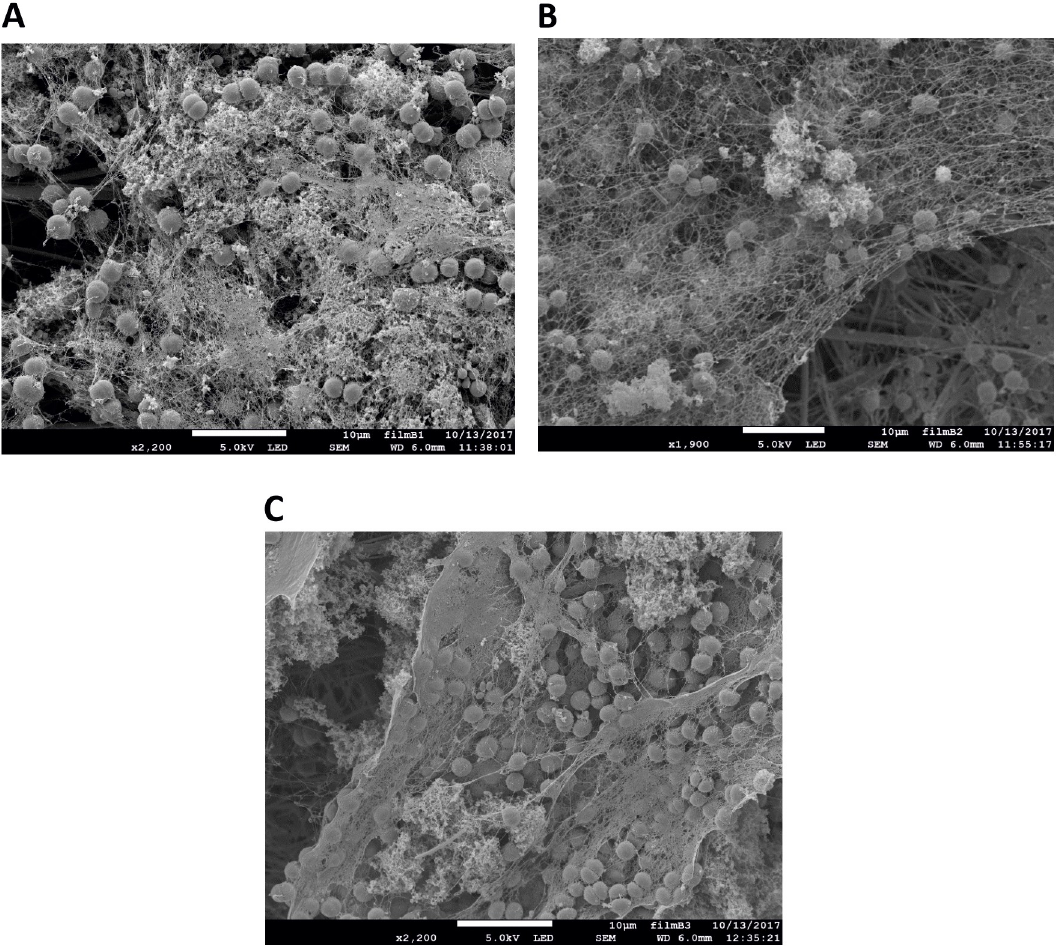
Fig 4. SEM of biofilm formation by Synechocystis on glass microfiber filter coated with PHB after 7 days of incubation. (A) 1 layer at 2200X magnification, (B) 2 layers at 1900X magnification, (C) 3 layers of PHB coating at 2200X magnification (Bar is 10 μ m in each